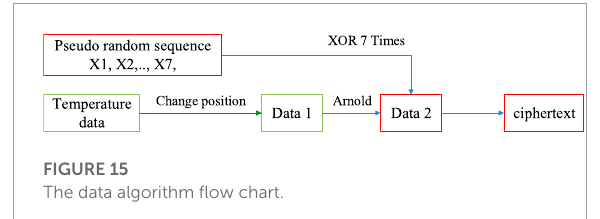
FIGURE 15 The data algorithm flow